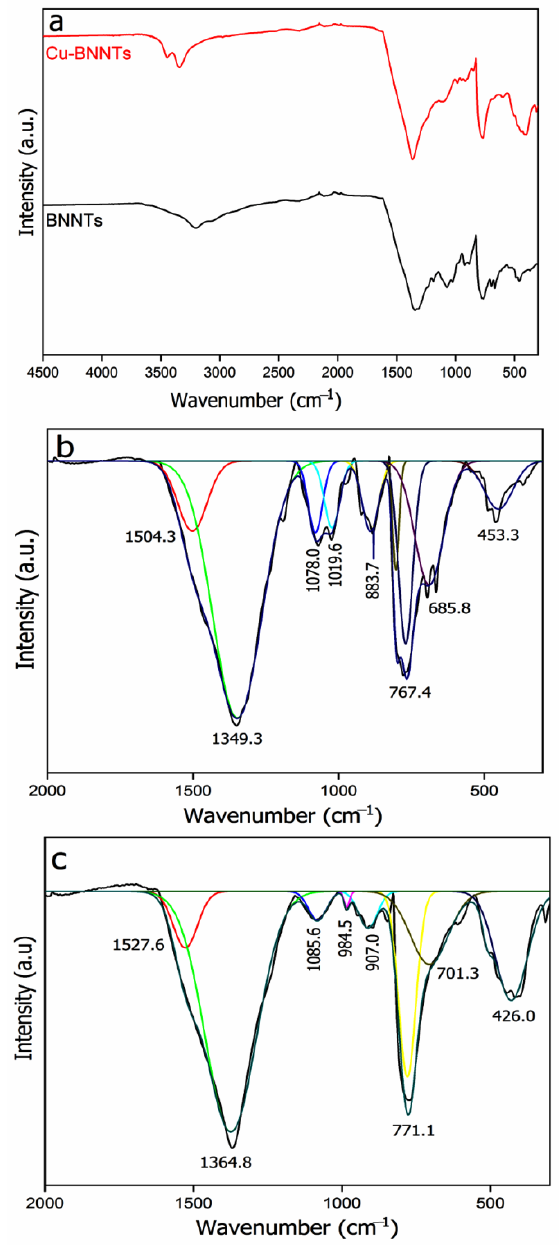
Figure 2. Infrared spectra of ( a ) BNNTs and Cu-BNNTs in the region between 4500 and 60 cm − 1 . Highlighted regions between 2000 and 60 cm − 1 for ( b ) BNNTs and ( c ) Cu-BNNTs.